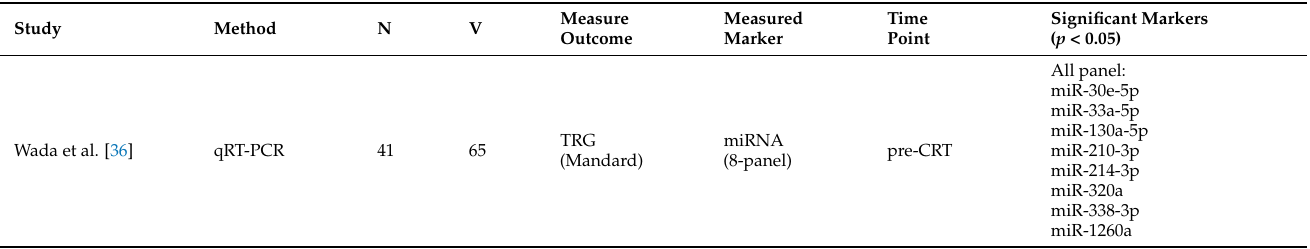
Table 5. Studies exploring miRNA as a biomarker predictive of tumor regression following